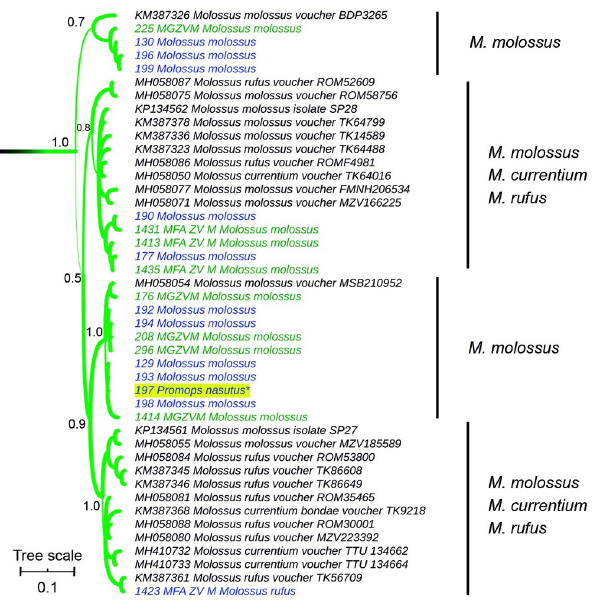
Fig 8. Cytochrome b -based Bayesian phylogeny of Molossus . Main clades posterior probability values are annotated. Branch width represents internal node support. Terminal font color indicates sequence source: black indicates sequences retrieved from Genbank, green indicates museum voucher sequences obtained in this study, while blue color indicates samples captured at the field and sequenced in this study. The scale units are substitutions per site.